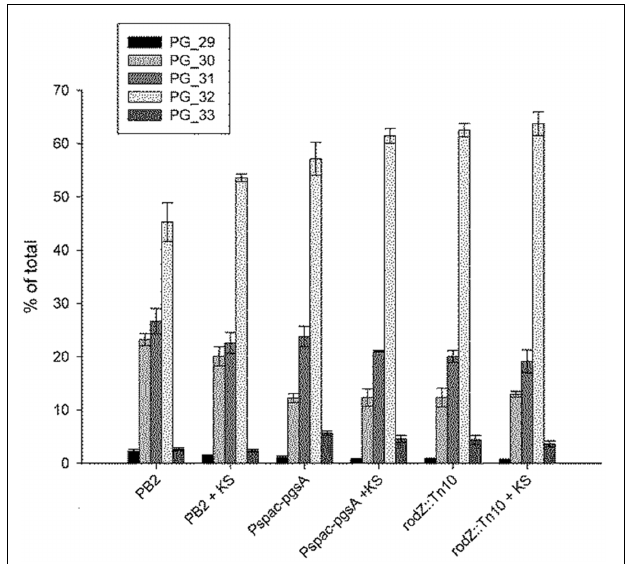
FIGURE 3 | Increased average acyl-chain length of phosphatidylglycerol (PG) in the rodZ transposon and conditional pgsA mutant, and increased lengths in the WT strain upon sorbic acid stress. The acyl chain distribution was measured in exponentially growing cells of the WT (PB2), pgsA ::P spac-pgsA and rodZ ::mini-Tn 10 mutant strains 45 min after treatment with or without 5 mM KS. The PG acyl chain composition is given as a percentage of the total observed PG levels per strain. The number behind PG in the legend indicates the number of carbon atoms per molecule in the acyl chain.